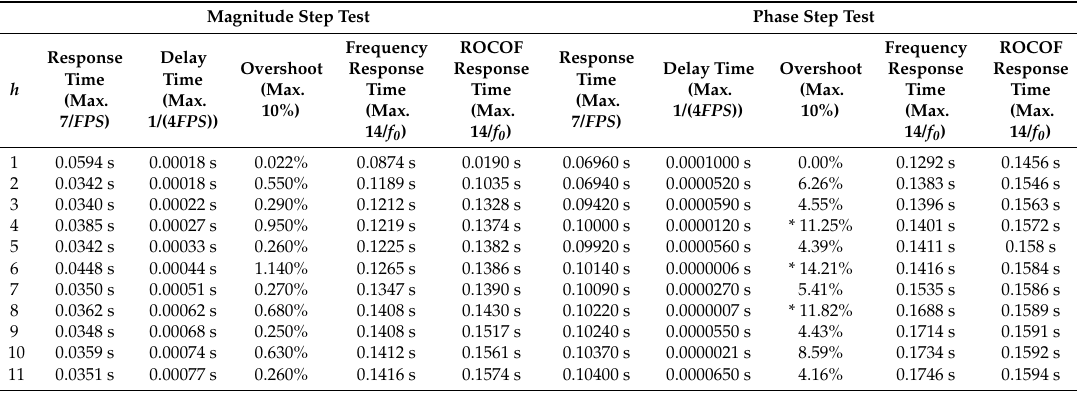
Table 2. Magnitude and phase tests results for each harmonic